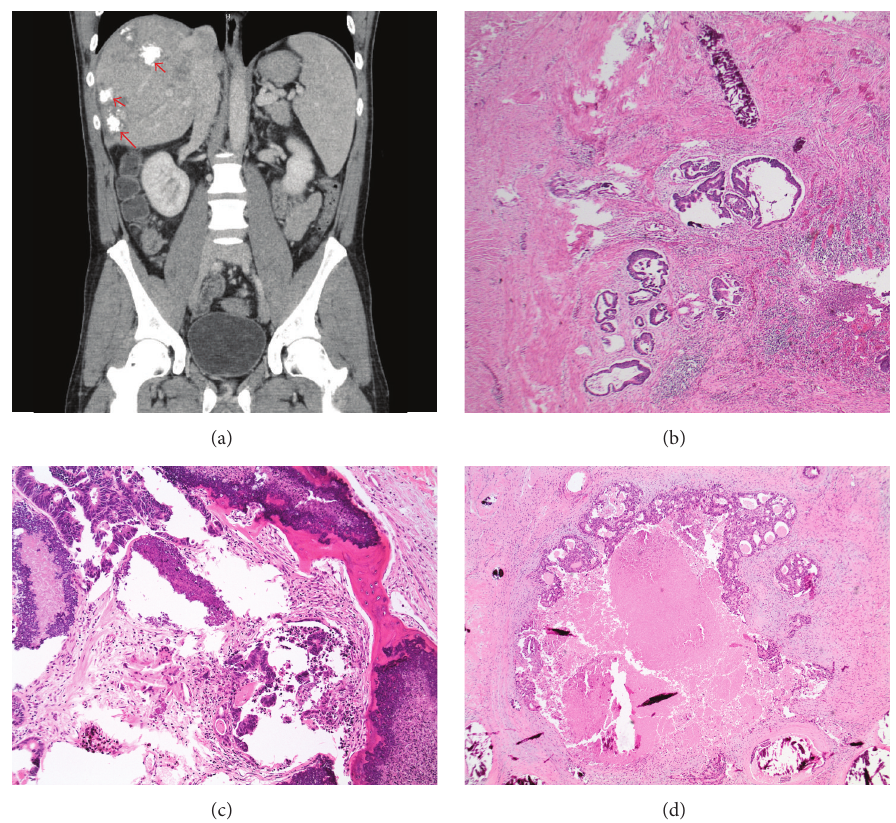
Figure 3: Case 2 histologic features of the sigmoid colon mass, lymph node, and liver masses. (a) CT scan of the abdomen demonstrated liver metastases with marked calcifications within the lesion (red arrow). (b) Left hemicolectomy of the sigmoid colon mass demonstrated moderately differentiated infiltrating neoplastic glands within ulcerated colonic mucosa consistent with primary colonic adenocarcinoma with associated calcifications (H&E, 40x). (c) Resection of lymph node showed foci of metastatic neoplastic glandular cells of colonic primary with associated osteoblastic activity demonstrated by bone formation and calcifications (H&E, 100x). (d) Resections of the liver masses highlighted metastatic neoplastic glands of colonic primary with associated osteoblastic activity demonstrated by calcifications (H&E,